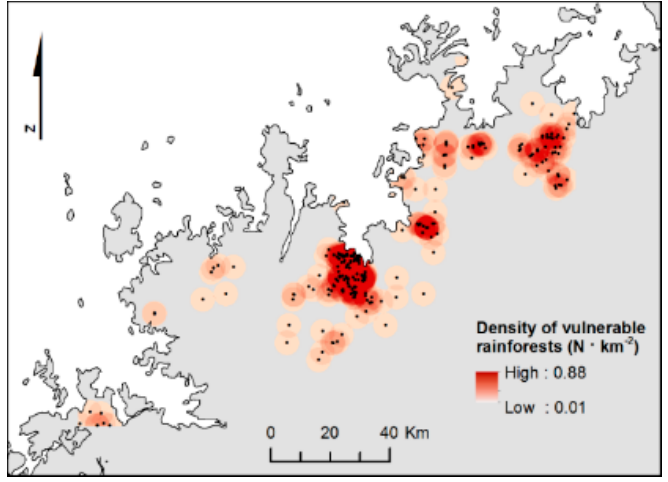
Figure 7. Location and density of the 5% most vulnerable rainforest patches, based on their size, distance from neighbouring patches, and fire frequency. The density map (red gradient) shows some clear clusters of vulnerable patches. Black dots represent single patches.